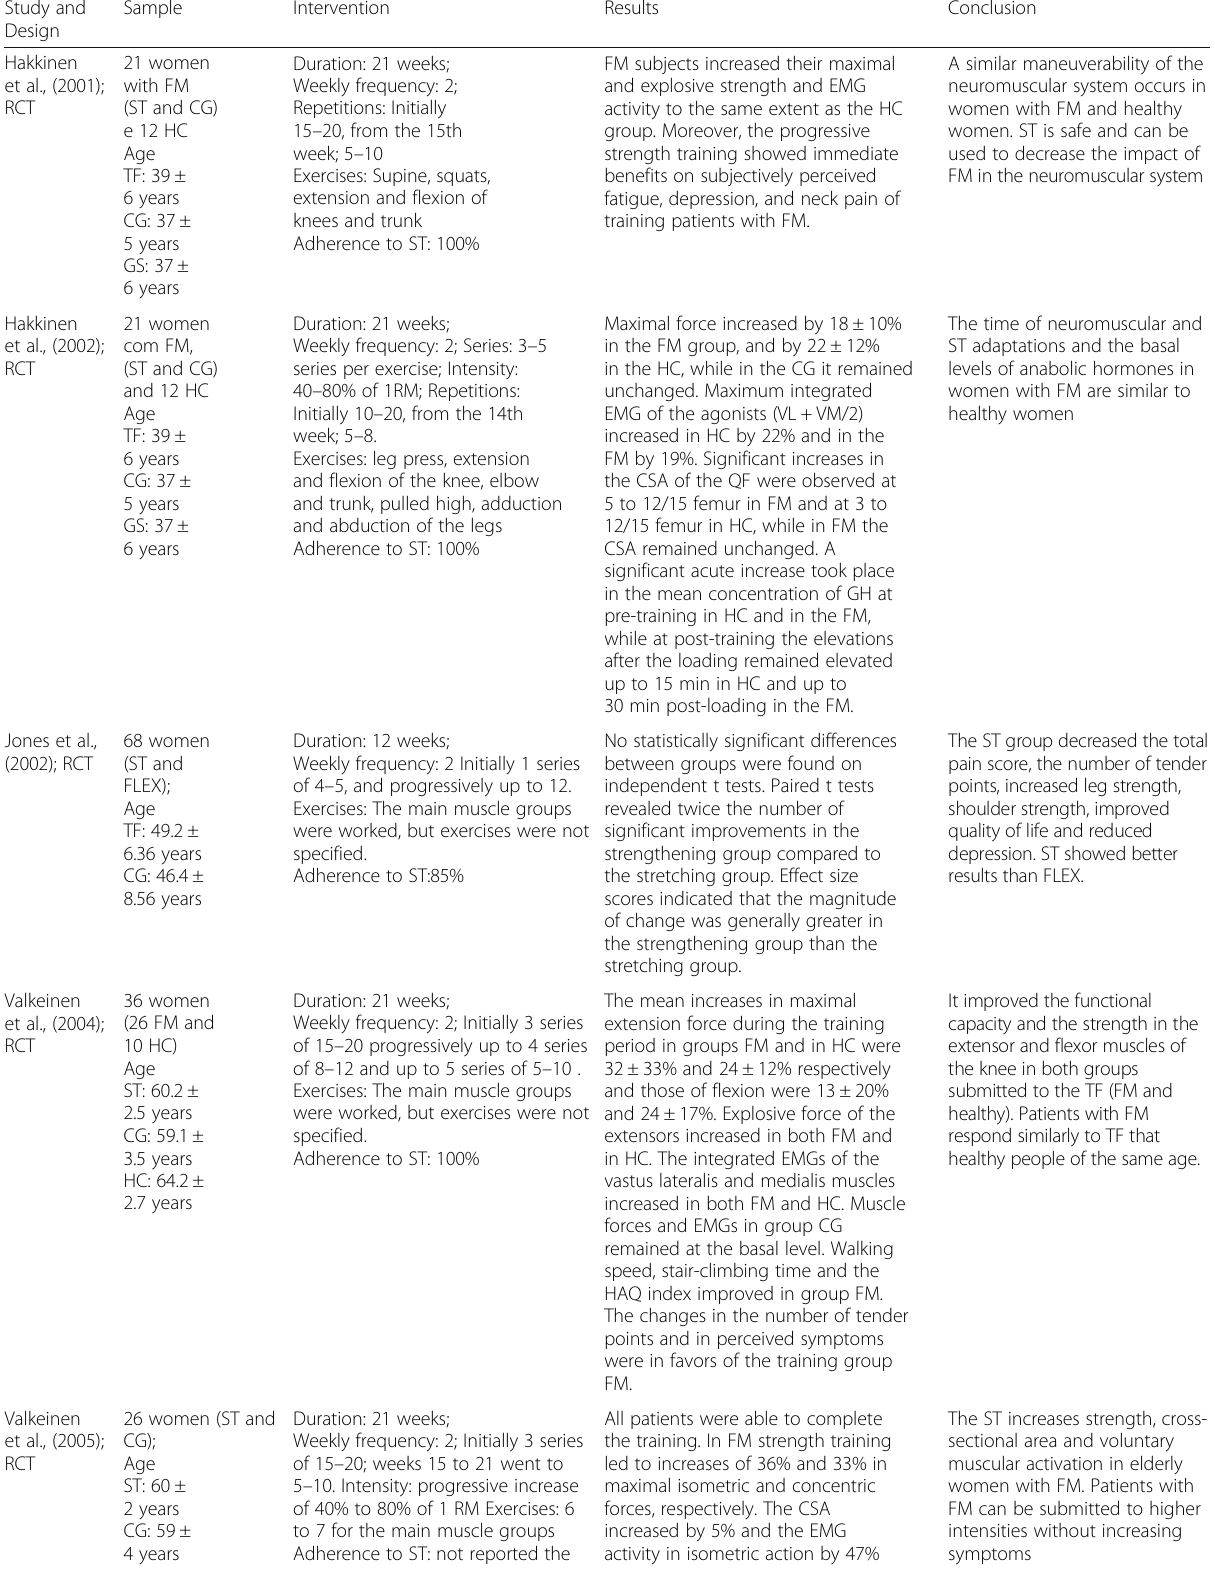
Table 2 Characteristics and results of experimental studies with strength training for patients with fibromyalgia syndrome Study and